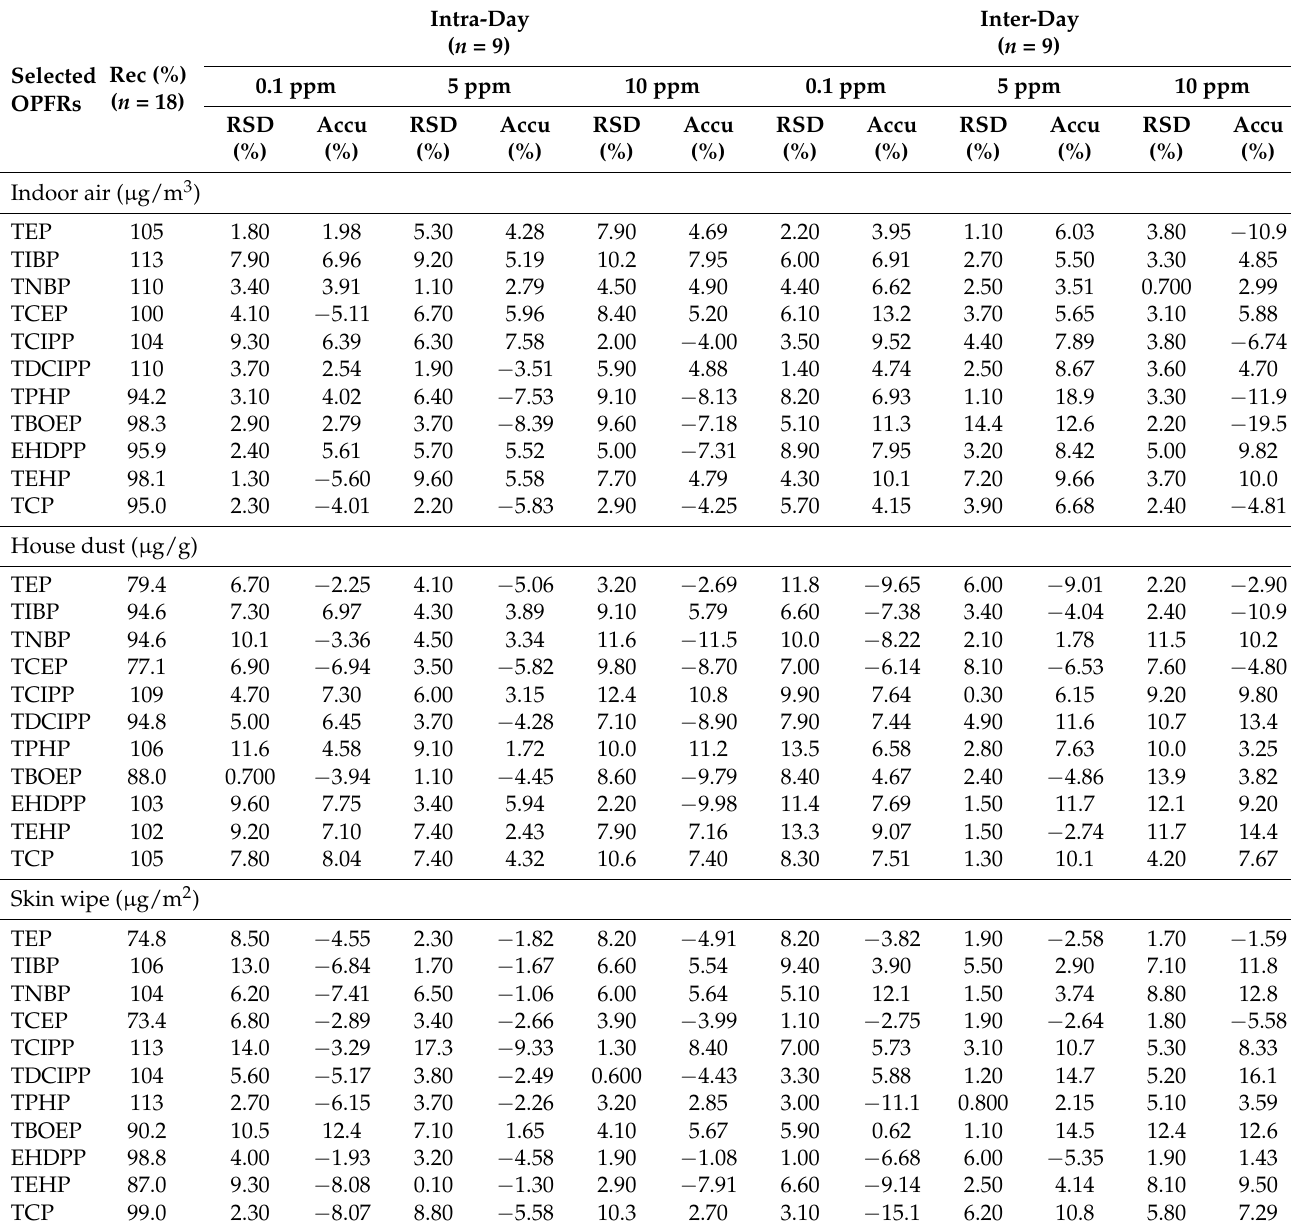
Table 2. Summary of method performance results in indoor air, house dust and skin